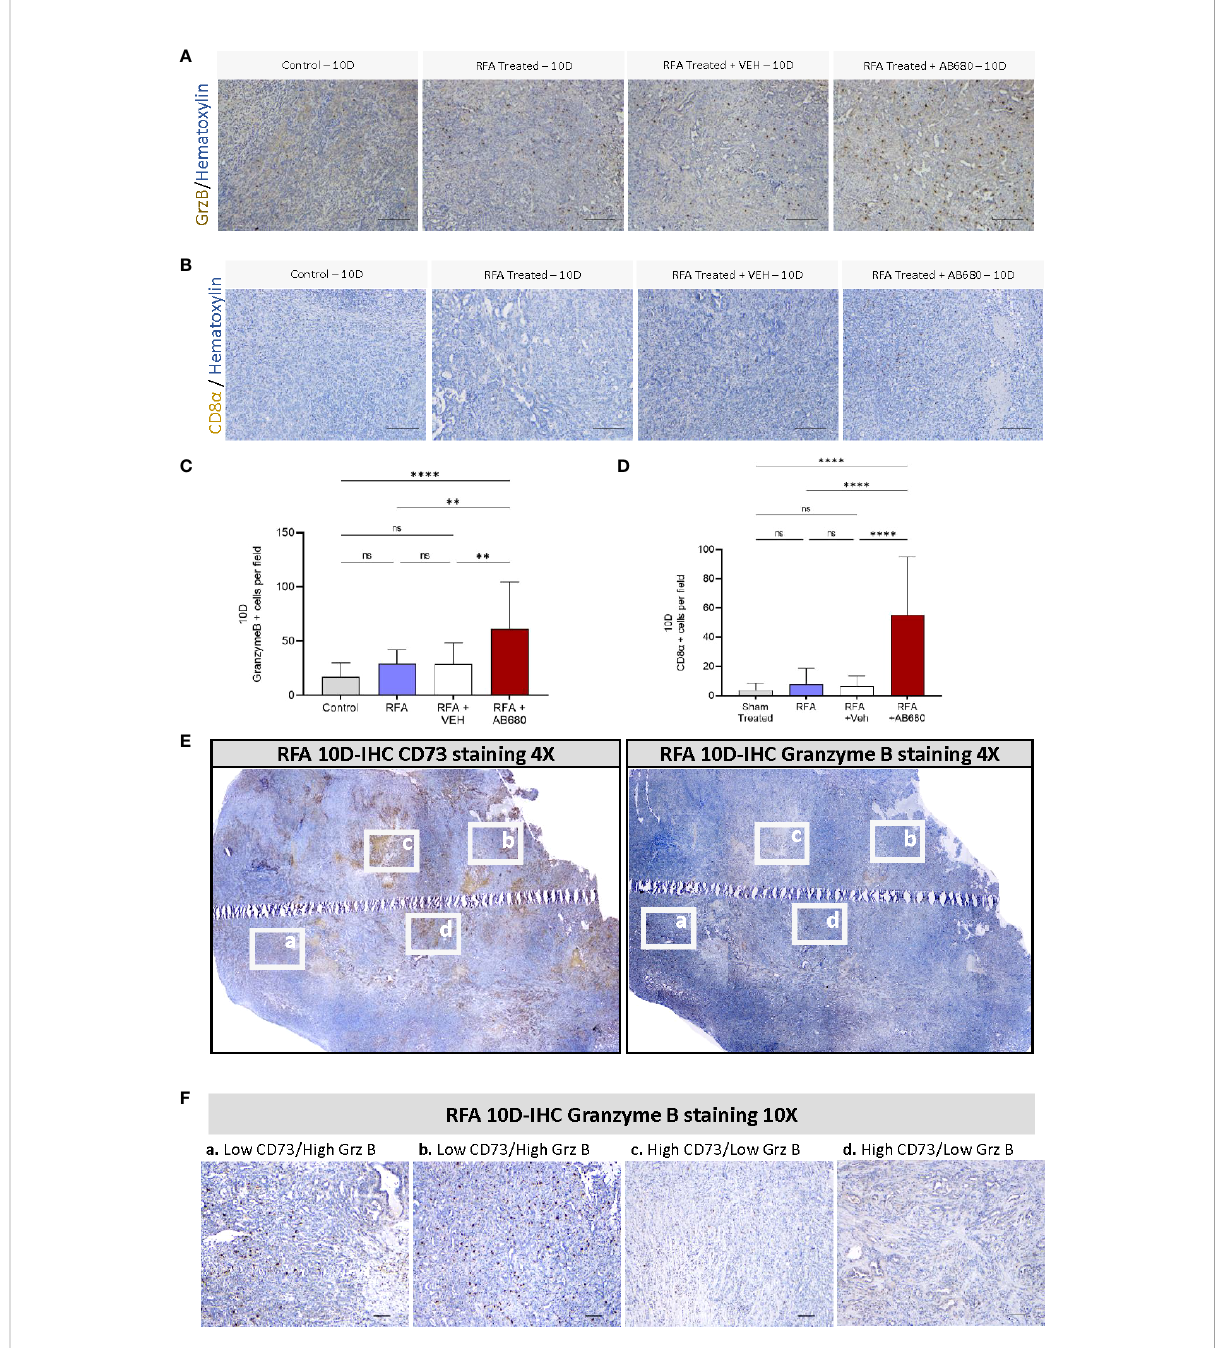
FIGURE 3 CD73 presents a negative spatial correlation with anti-tumor immunity. (A, C) Analysis of Granzyme B IHC staining from RFA + AB680 treated tumors 10 days after ablation revealed increased abundance of Granzyme B + cells when compared to KPC control tumors subcutaneously grown up to 10 days (p < 0.0001), RFA (p < 0.01) and RFA+VEH (p < 0.01) treated mice . (B, D) Analysis of CD8 a positive cells IHC staining from RFA + AB680 treated tumors 10 days after ablation revealed increased abundance of CD8 a + cells when compared to KPC control tumors subcutaneously grown up to 10 days, RFA and RFA+VEH treated mice (p < 0.0001). (E) At 10 days after treatment, a negative correlation was observed between CD73 protein expression (Left) and abundance of Granzyme B + cells (Right) in composite pictures of RFA treated KPC subcutaneous tumors taken at 4X after IHC. (F) Higher magni fi cation images reveal areas with decreased CD73 expression present increased granzyme B+ cells (Left panels, a and b), whereas areas with increased CD73 expression show decreased Granzyme B+ cells (Right panels, c and d), suggesting elevated antitumor immunity in areas with lower ADO generation. One-way ANOVA (C, D) were used for group comparisons. Bars represent 50uM. **p<0.01; ****p<0.0001; ns (not signi fi